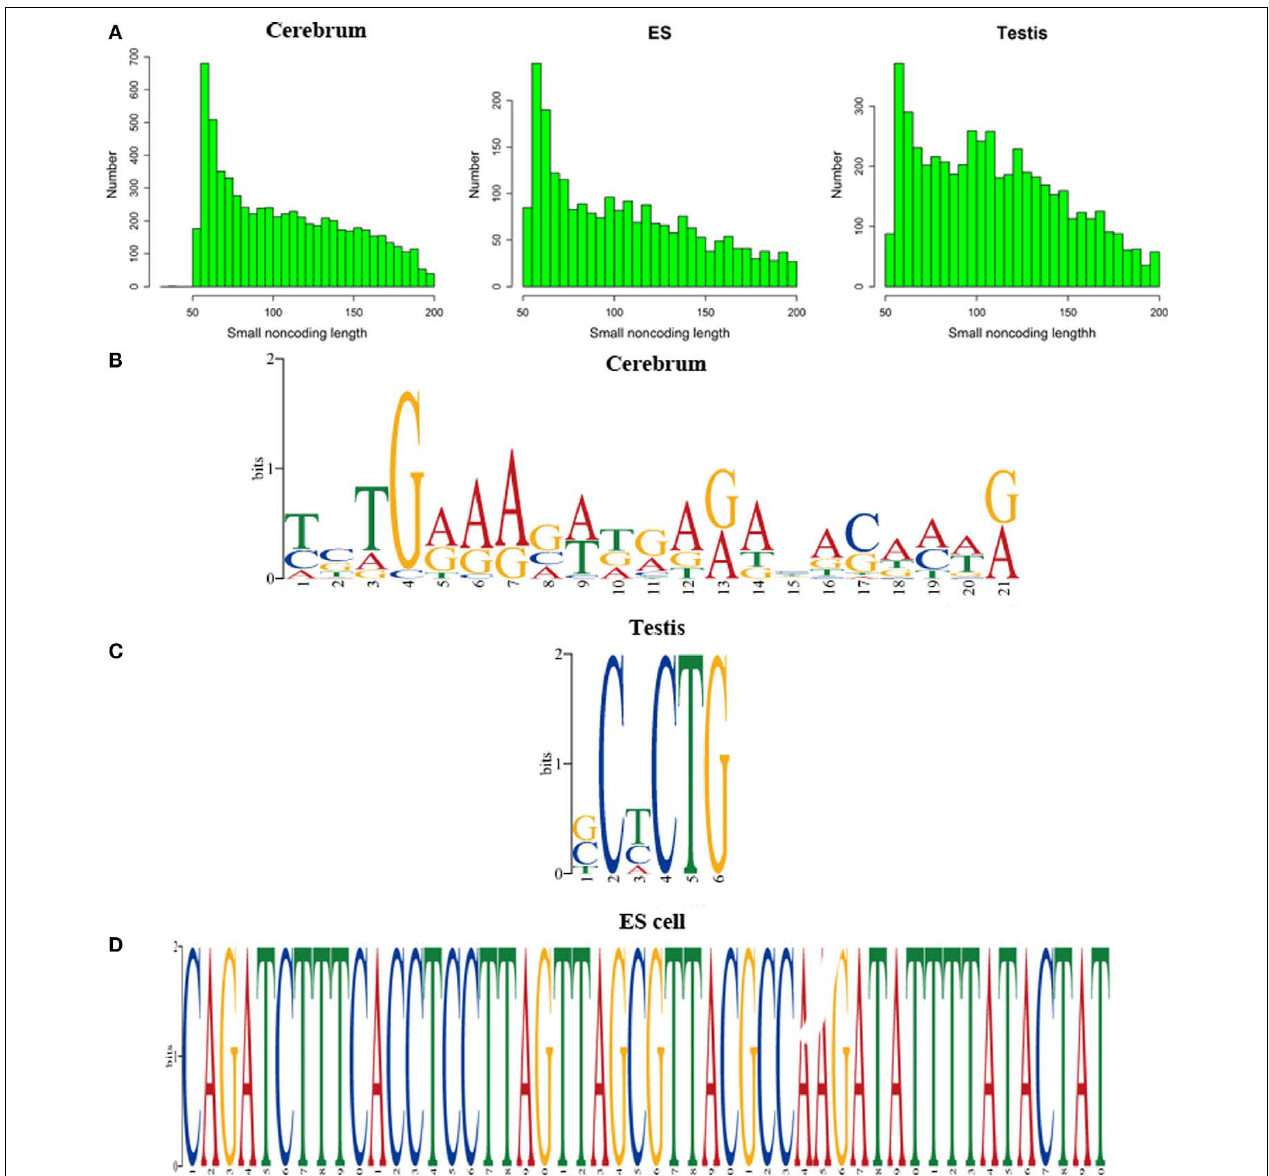
motif logo of small RNA in testis (41.54% of 64bp small RNAs involved in this motif), and (D) a motif logo of small RNAs in ES cell (25.97% of 56bp small RNAs involved in this